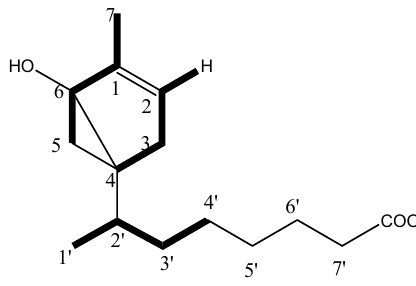
Figure 5. Key 1 H- 1 H Cosy correlations of compound 3 . Table 1. 1 H-NMR (400 MHz) and 13 C-NMR (100 MHz) data of compounds 1 and 2 (in CDCl 3 ).